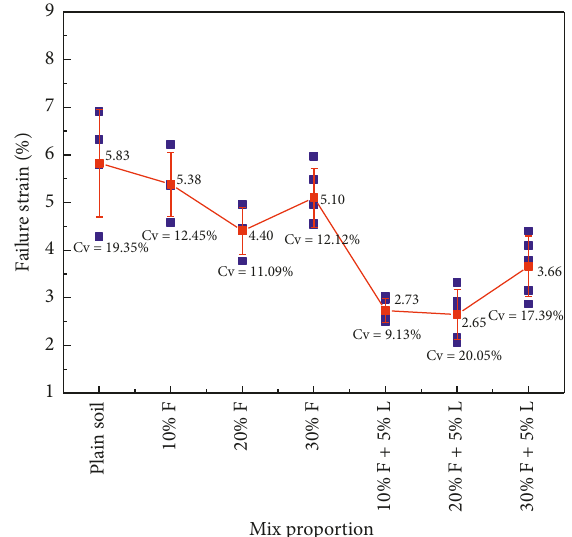
Figure 12: Unconfined compressive failure strain curve of stabi- lized soil (28